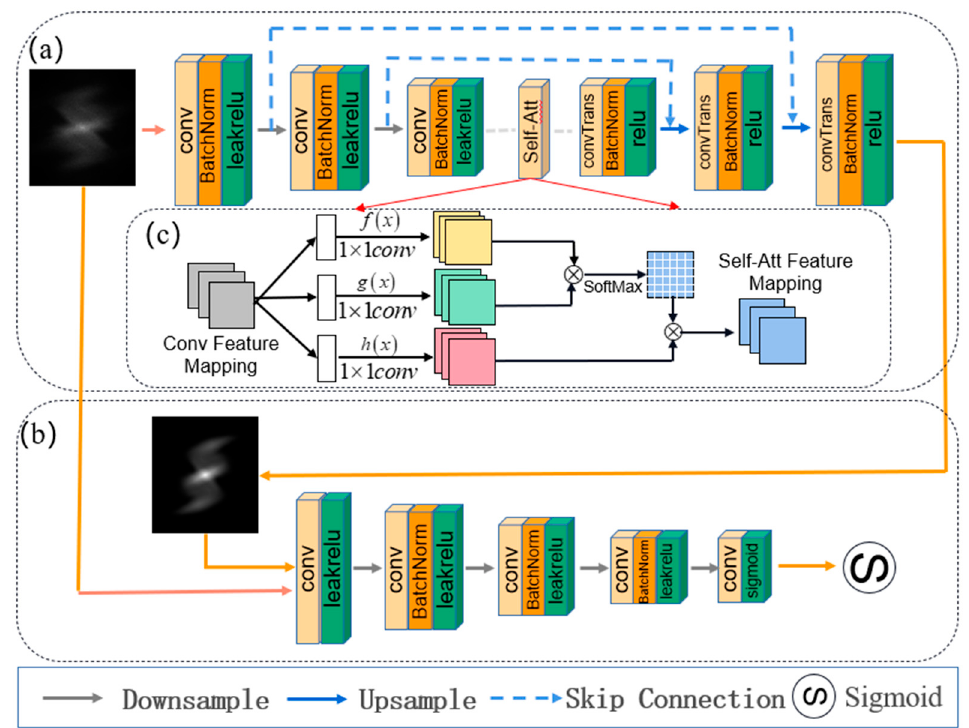
Figure 4. Deep-learning model: ( a ) generative network; ( b ) discriminative network; ( c ) the self-attentive mechanism.